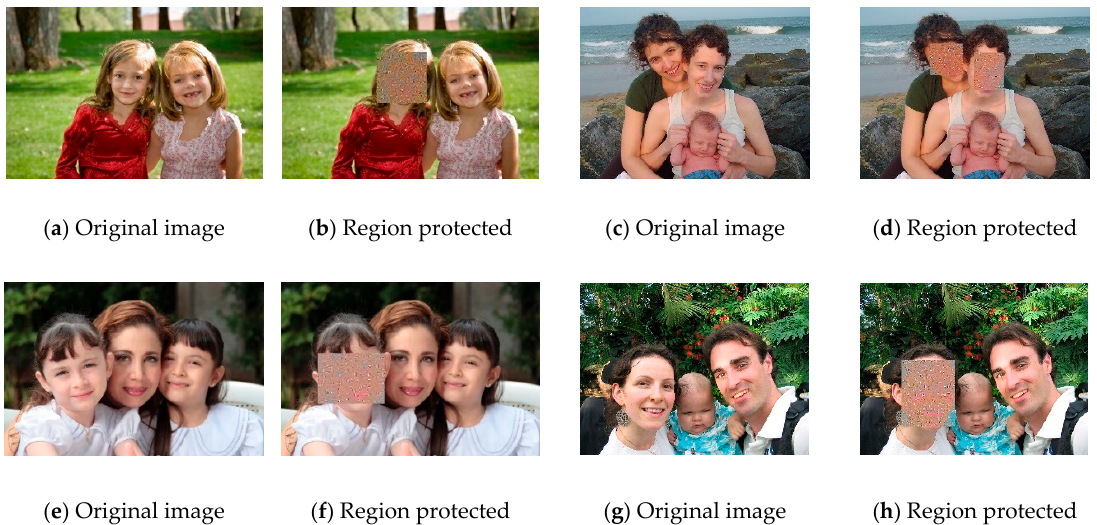
Figure 5. Four JPEG images and the ones with user-selected regions protected.